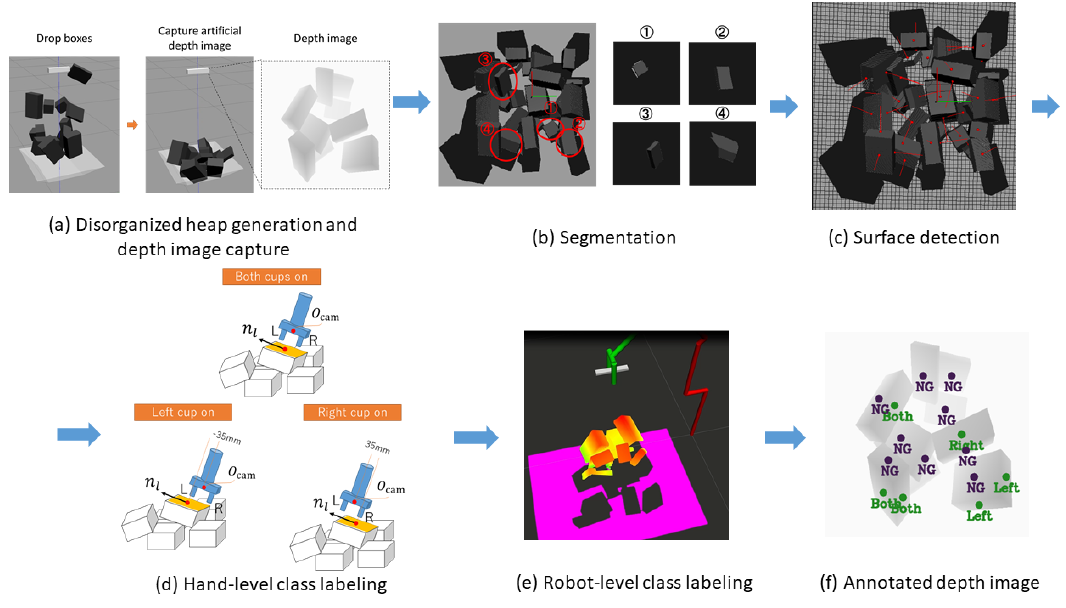
Figure 4. Automatic training dataset collection framework. ( a ) Disorganized heap generation and depth image capture. ( b ) Segmentation. ( c ) Surface detection. ( d ) Hand-level class labeling. ( e ) Robot-level class labeling. ( f ) Annotated depth